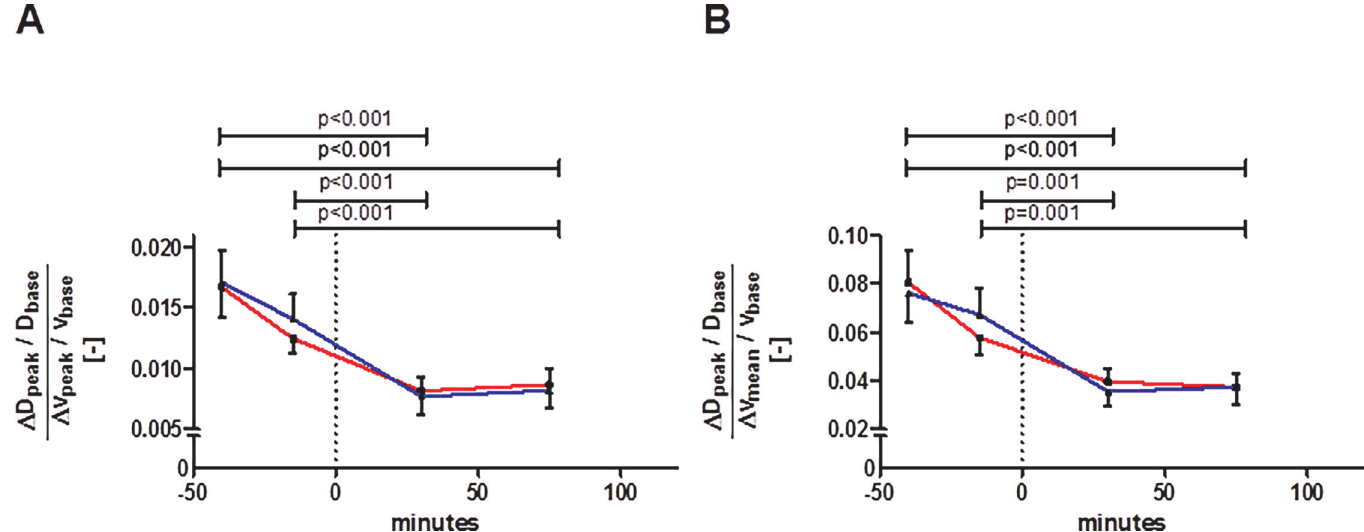
Figure 3. Changes in mFMD v (A) and in pFMD v (B) with glucose loading. Glucose was ingested at time-point 0 minutes (dashed vertical line). Red line: session 1, blue line: session 2; whiskers indicate standard error. Data did not differ between sessions at any corresponding time-point (all p-values (cid:3) 0.176, n = 22). The p-values on top of the graphs refer to differences between pre and post glucose intake (of the mean of both sessions). Abbreviations as defined in Table 1.